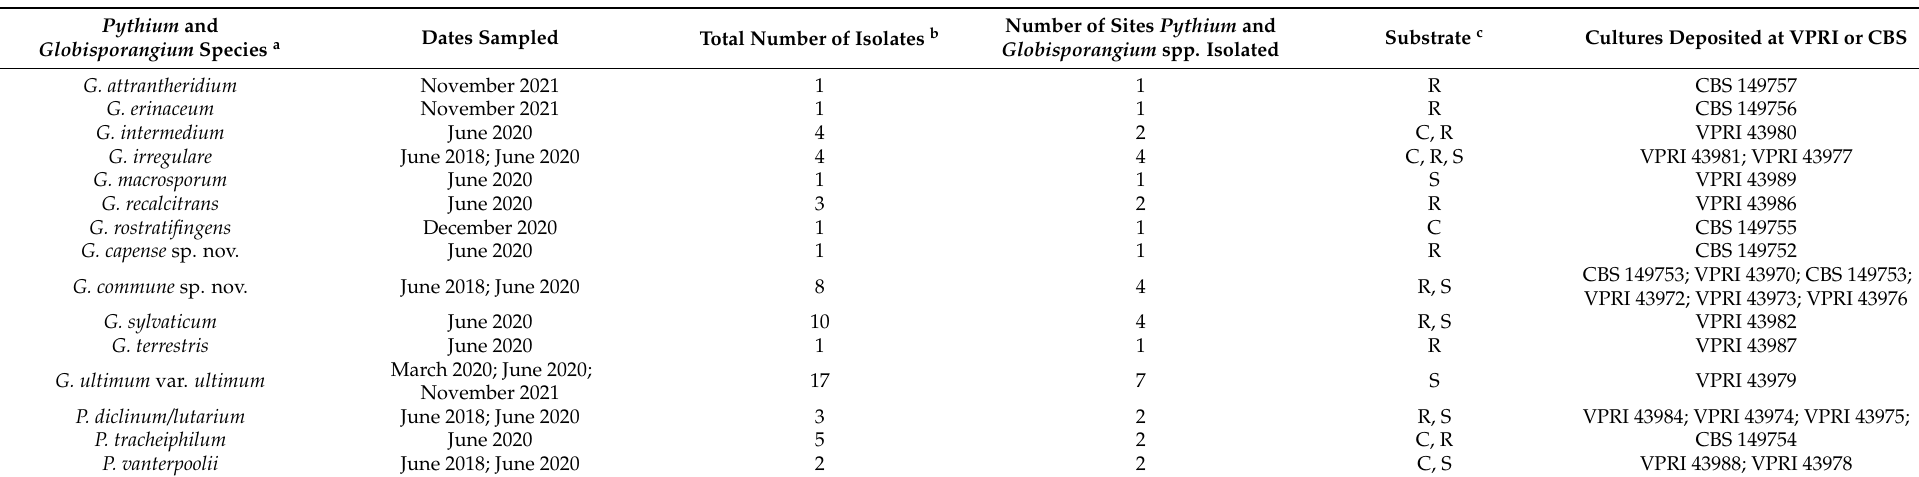
Table 1. Details of Pythium and Globisporangium species isolated from pyrethrum plants or soil. Pythium and Dates Sampled Total Number of Isolates b Globisporangium Species a